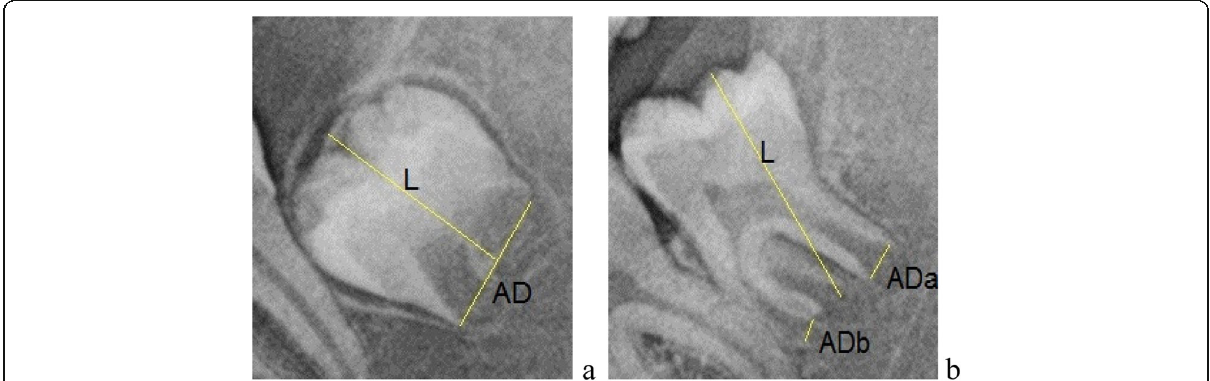
Fig. 1 Measurements of a tooth with one root ( a ) and two roots ( b ) where AD apical distance, L